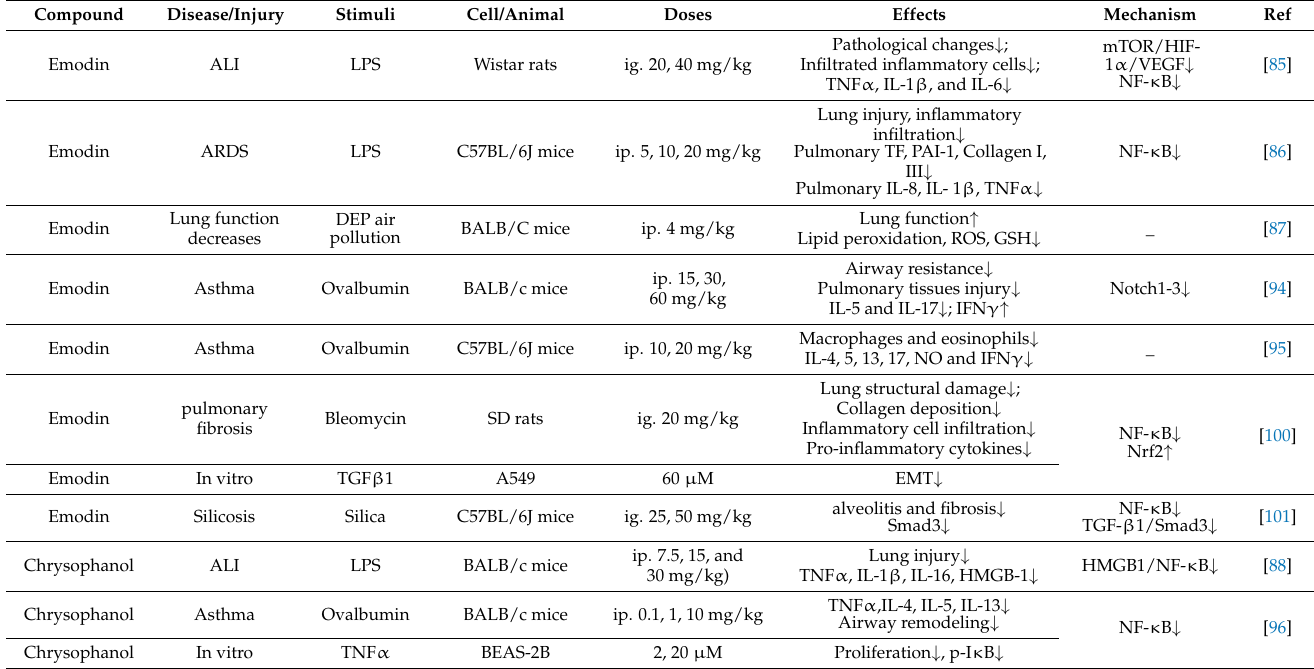
Table 3. Effects and mechanism of AQs on respiratory